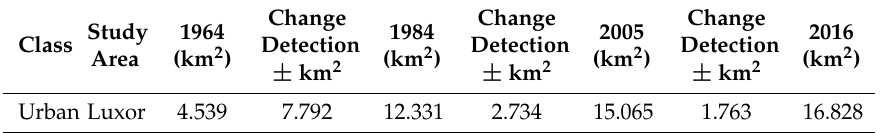
Table 3. Total changes in the urban and agriculture areas (expressed in km 2 ) in Luxor area. Study Class